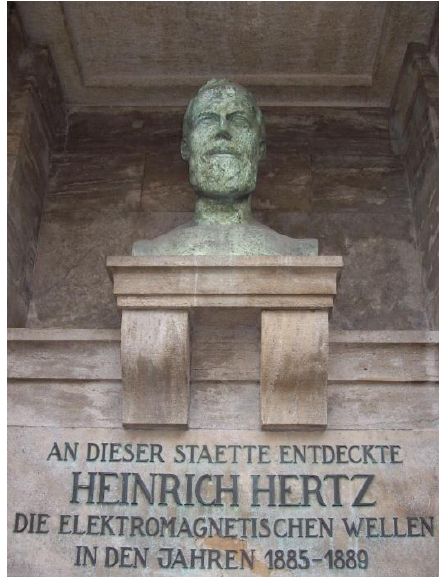
Figure 1: Bust of Heinrich Hertz at the Karlsruhe Institute for Technology, created by his daughter Mathilde and unveiled on 30 October 1925 at the occasion of 100 th anniversary of the University Fridericiana (Technical Highschool) Karlsruhe [2]. Photo by Klaus-Dieter Keller (public